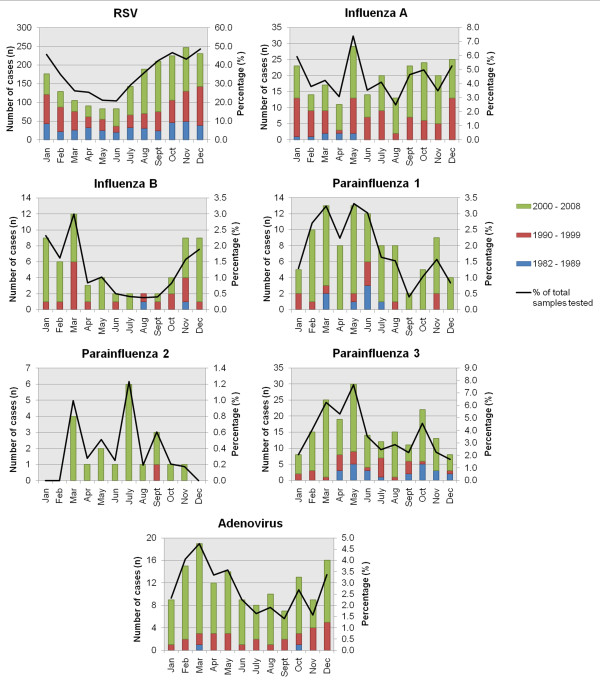
Within-year seasonality patterns of respiratory viruses. Cases over 27 years were aggregated according to the month the specimen was received. The figure includes percentage rates of detection of each virus when divided by the total number of samples tested. This shows that the observed monthly trends were not affected by the total number of samples received.